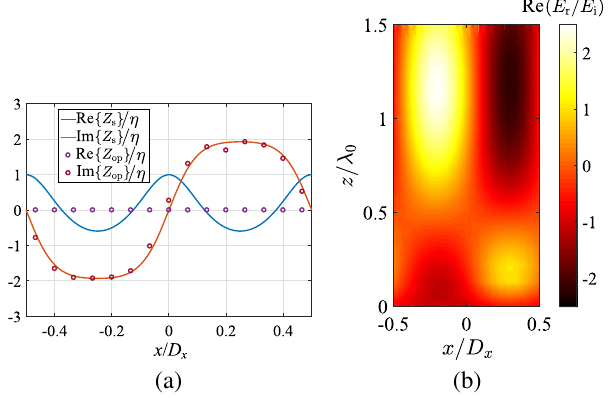
FIG. 8. A 50 ∶ 0 ∶ 50 power splitter. (a) Surface impedance dictated by Eq. (7) shown with solid lines and optimized surface impedance shown with circles. (b) A snapshot of the scattered normalized electric field (real value) in the proximity of the splitter located at z ¼ 0 . The splitter is modeled by an ideal sheet, with the optimized surface impedance profile shown in Fig. 8(a).